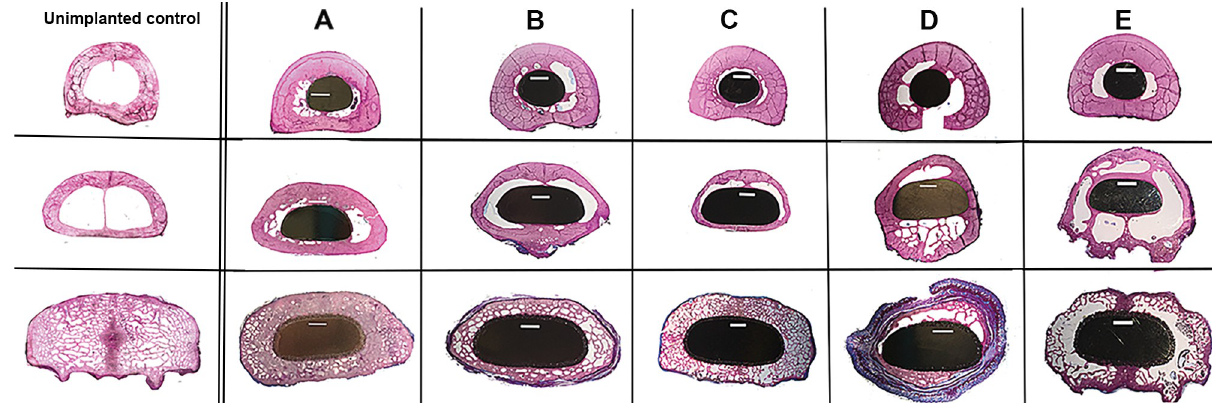
Fig 5. Cross-sectional images of a non-implanted control animal with representative bone-endoprosthesis cross-sections of the five experimental animals (A-E), stained with Sanderson Rapid Bone Stain. Sections were taken from different regions along the length of the endoprosthesis. The top row shows images from the smooth region of the endoprostheses, see Fig 4, Regions (a) or (b) or (c). The middle row shows images from the fluted regions of the endoprostheses, see Fig 4 , Regions (d) or (e). The bottom row shows images from the porous coated region, of the endoprostheses, see Fig 4 , Region (f). At surgery, the porous coated region was impacted into the cancellous metaphyseal bone. Pink = mineralized tissue (bone), black = endoprosthesis and blue = fibrous tissue. Scale bar = 3mm.